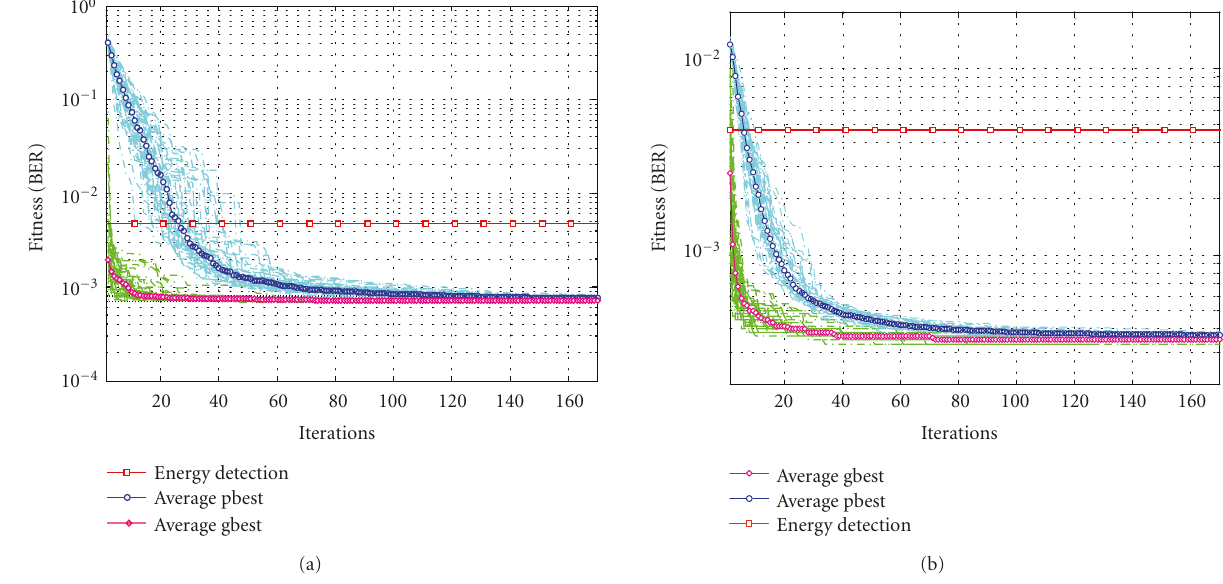
Figure 4: The PSO Fitness versus iterations. (a) ERFC scheme; (b) OFC scheme. Notice the E b /N o is 12.5